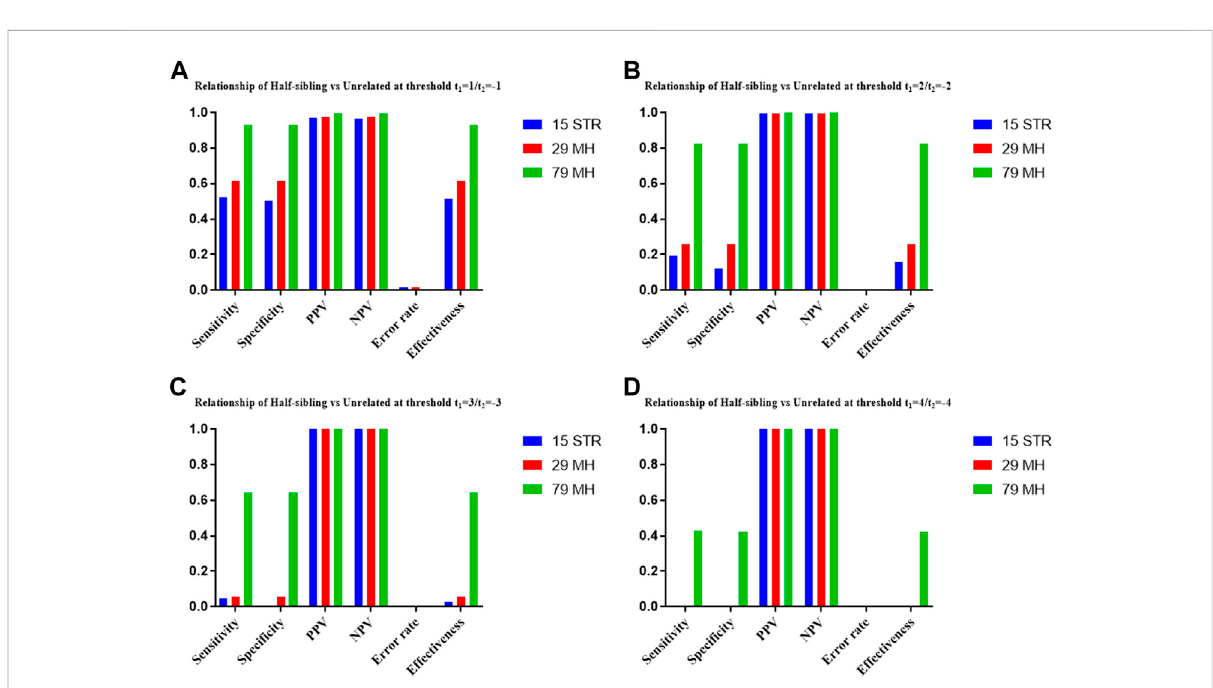
FIGURE 7 Thesystempowerbasedonthedataof15STRloci,29microhaplotypelociand79microhaplotypelociforrelationshiphalf-siblingvs.unrelated individuals at different threshold values. (A) Threshold t 1 = 1/t 2 = − 1; (B) Threshold t 1 = 2/t 2 = − 2; (C) Threshold t 1 = 3/t 2 = − 3; (D) Threshold t 1 = 4/t 2 = −